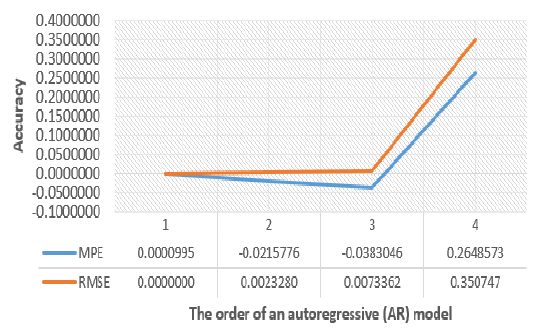
Figure 6 The effect of order variation in AR(p)